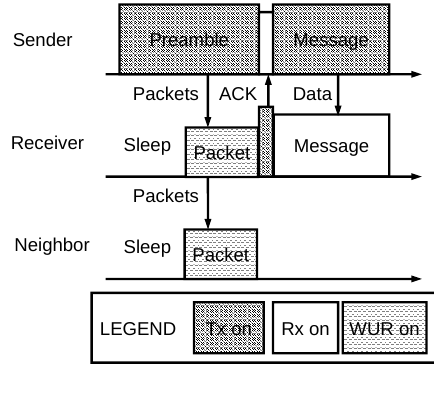
Figure 1. Wake-up